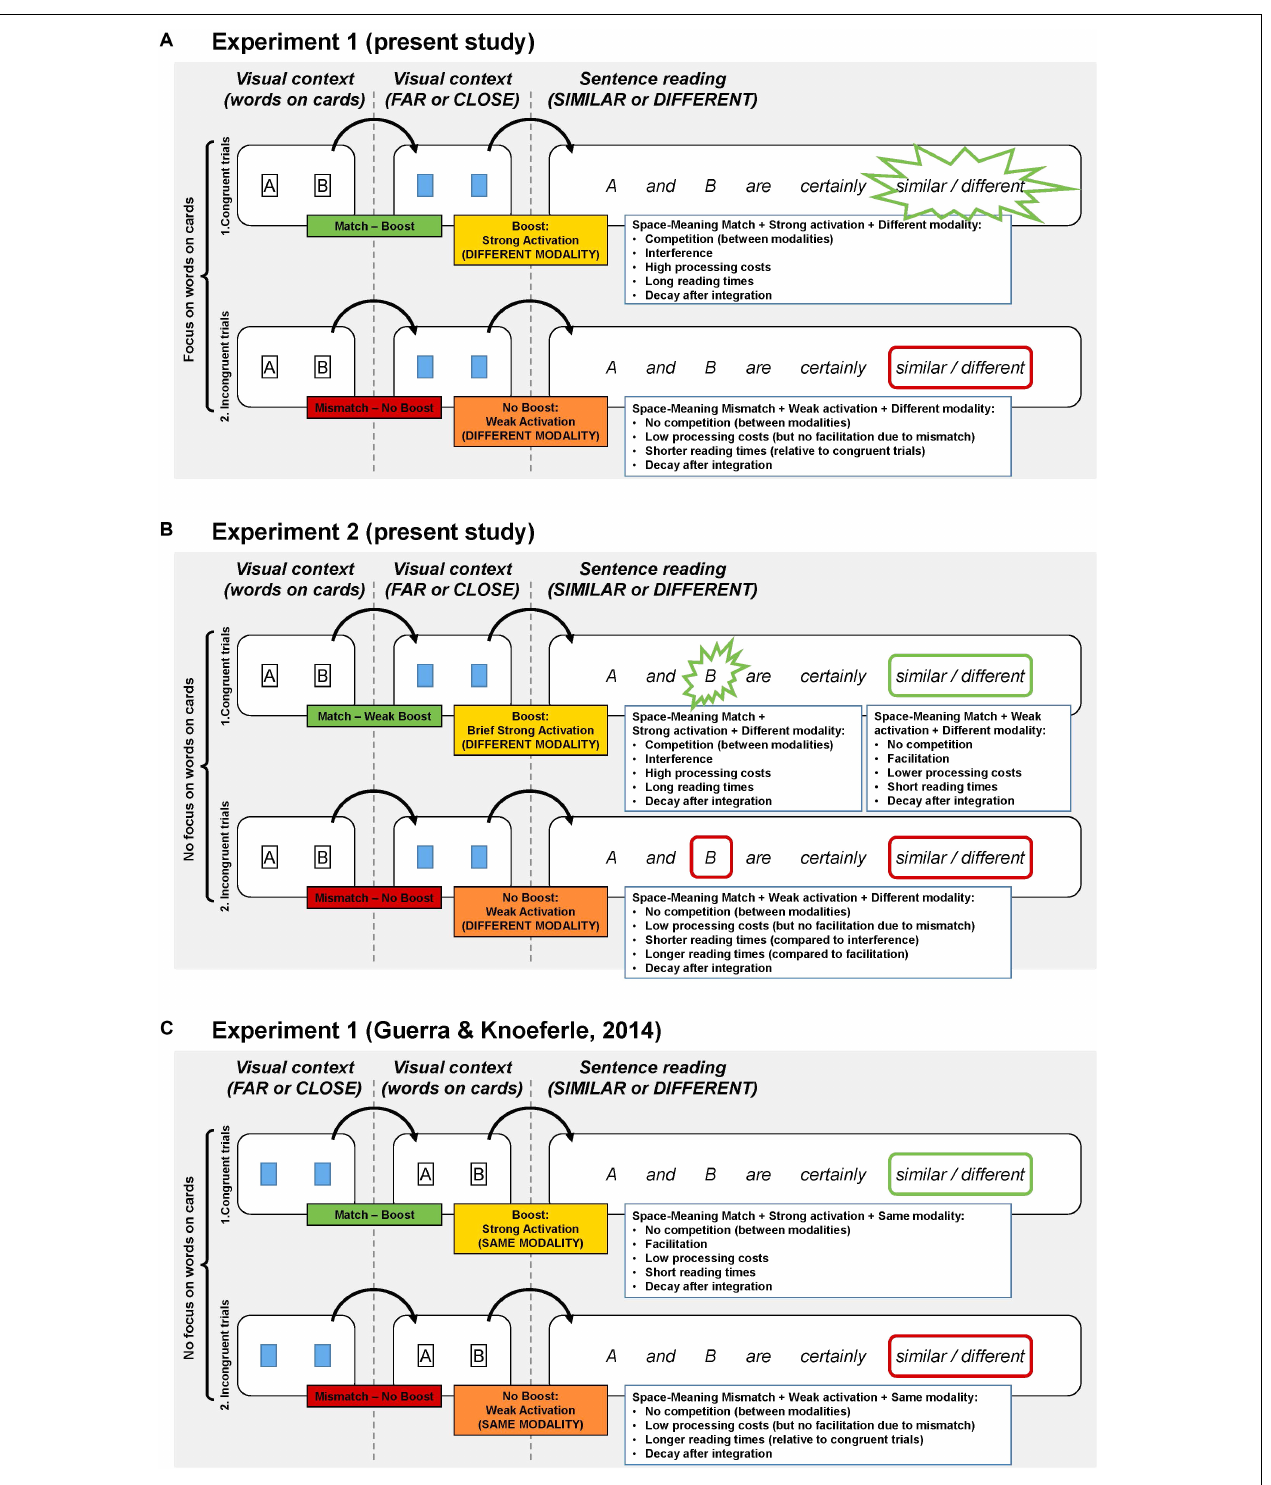
FIGURE 3 | Schematic representation of the hypothesized chain of processes for the present experiments (A,B) and Experiment 1 (C) from Guerra and Knoeferle (2014). In all three panels, 1 and 2 represent congruent and incongruent trials, respectively. They also show three critical stages: two visual context stages (distance: far or close; words on cards), and a sentence processing stage (conveying semantically similar or different content). Depending on the emphasis given to the words on the cards (A. vs. B. and C) and the presentation order of semantic and spatial information (A. and B. vs. C) the competition account predicts distinct consequences of the interplay between space and meaning on reading